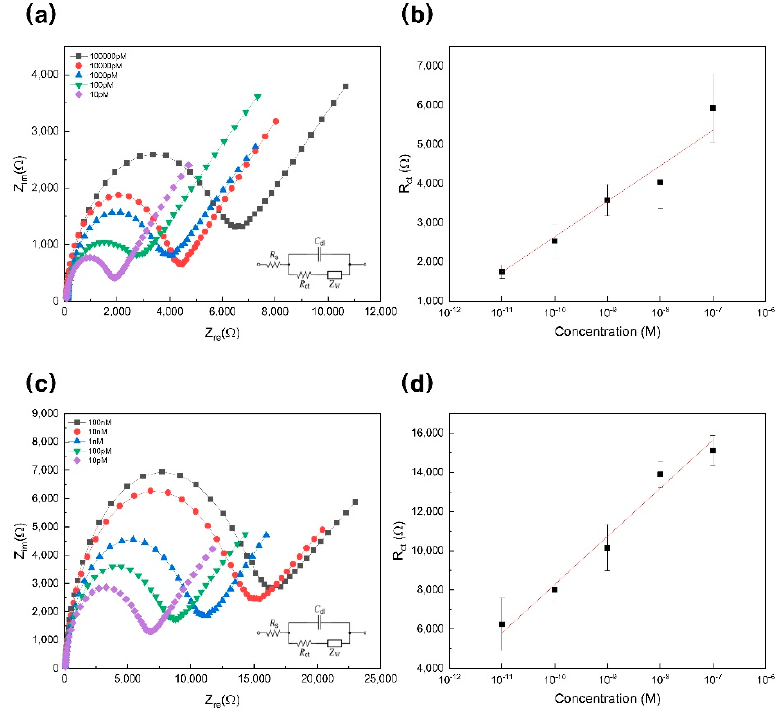
Figure 5. ( a ) Impedance spectra for different concentrations of H1N1 (artificial). ( b ) Linear regres- sion curve of different H1N1 concentrations; linear range from 100 nM to 10 pM. ( c ) Impedance spectra for different concentrations of H1N1 diluted with 10% human serum in 10 mM HEPES and 5 mM [Fe(CN) 6 ] 3-/4- . ( d ) Linear regression curve of different H1N1 concentrations in 10% human serum; linear range from 100 nM to 10 pM. HEPES, 4-(2-hydroxyethyl)-1-piperazineethanesulfonic acid.